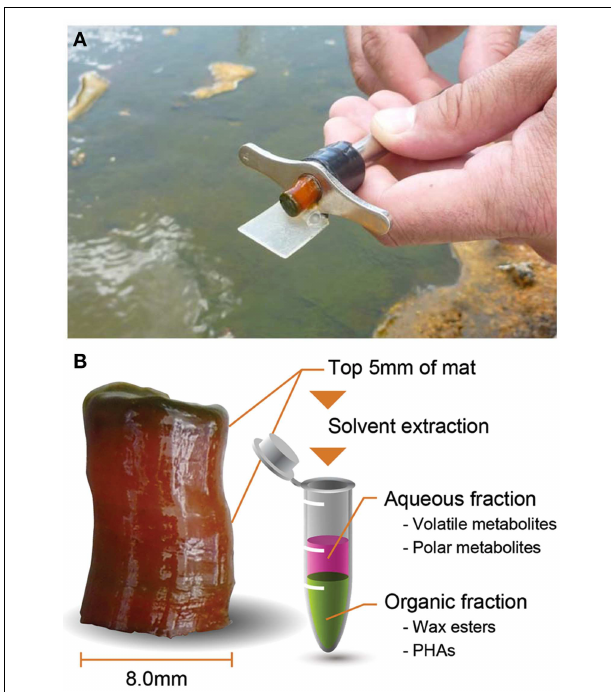
FIGURE 1 | Core sampling using a cork-borer in Mushroom Spring phototrophic mat (A) and longitudinal view of core sample and brief analytical scheme